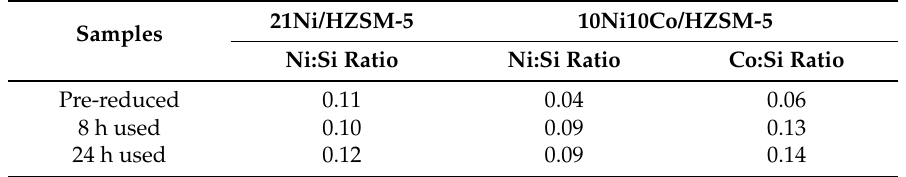
Table 3. Elemental composition of the near-surface region of fresh pre-reduced and spent catalysts. Samples